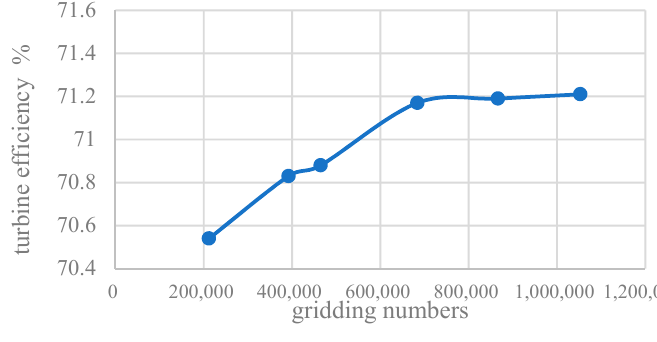
Figure 4. The grid study.